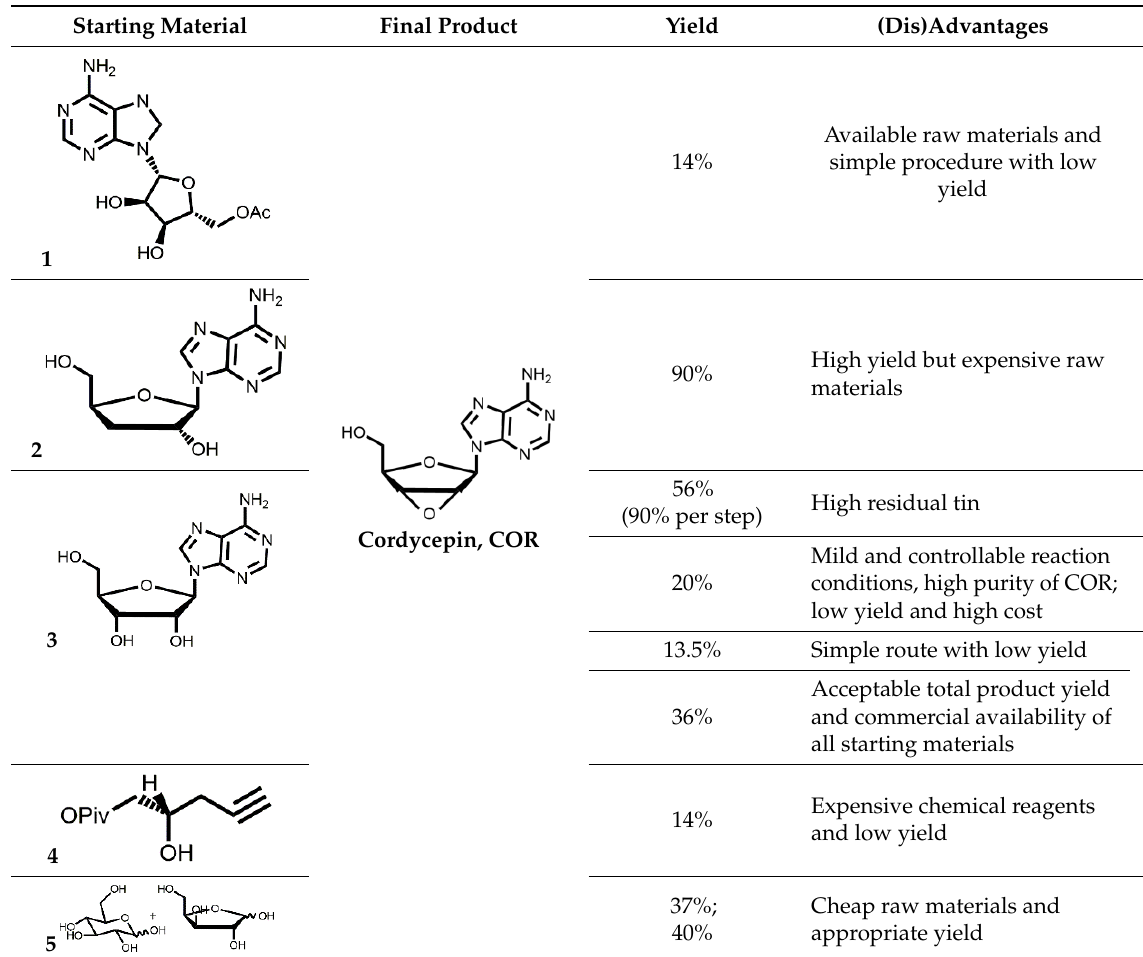
Table 1. The starting materials and yield of chemical synthesis of cordycepin (COR).